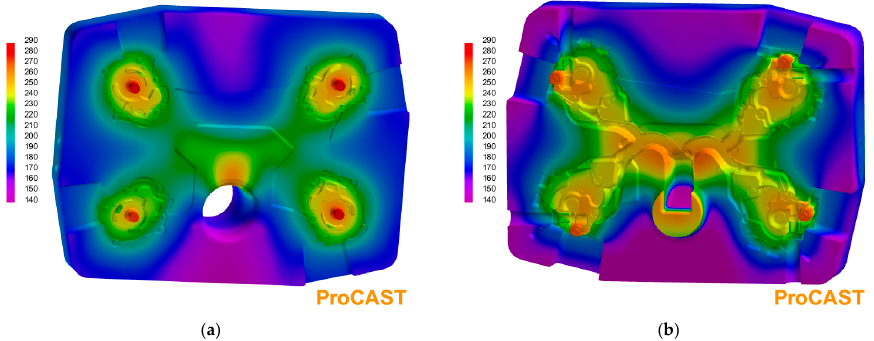
Figure 5. Temperature distribution on surfaces of forming inserts used as initial condition for simulation of die cavity filling: fixed die ( a ) and mobile die ( b ).